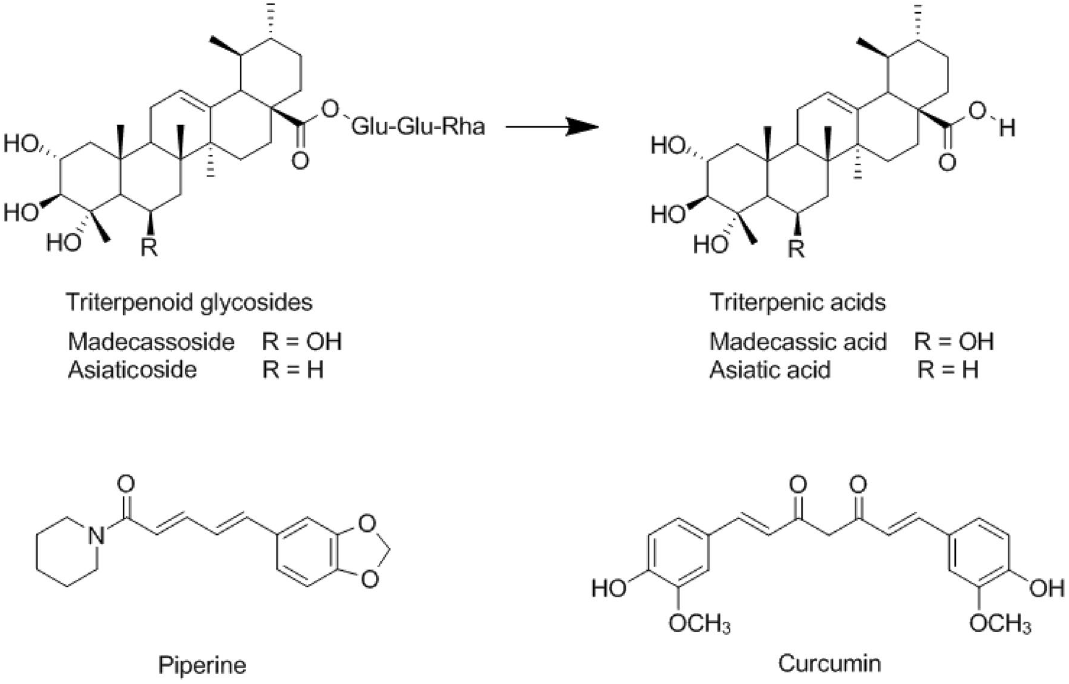
Figure 1. Chemical structures of piperine, curcumin and the bioactive triterpenoids of Centella asiatica